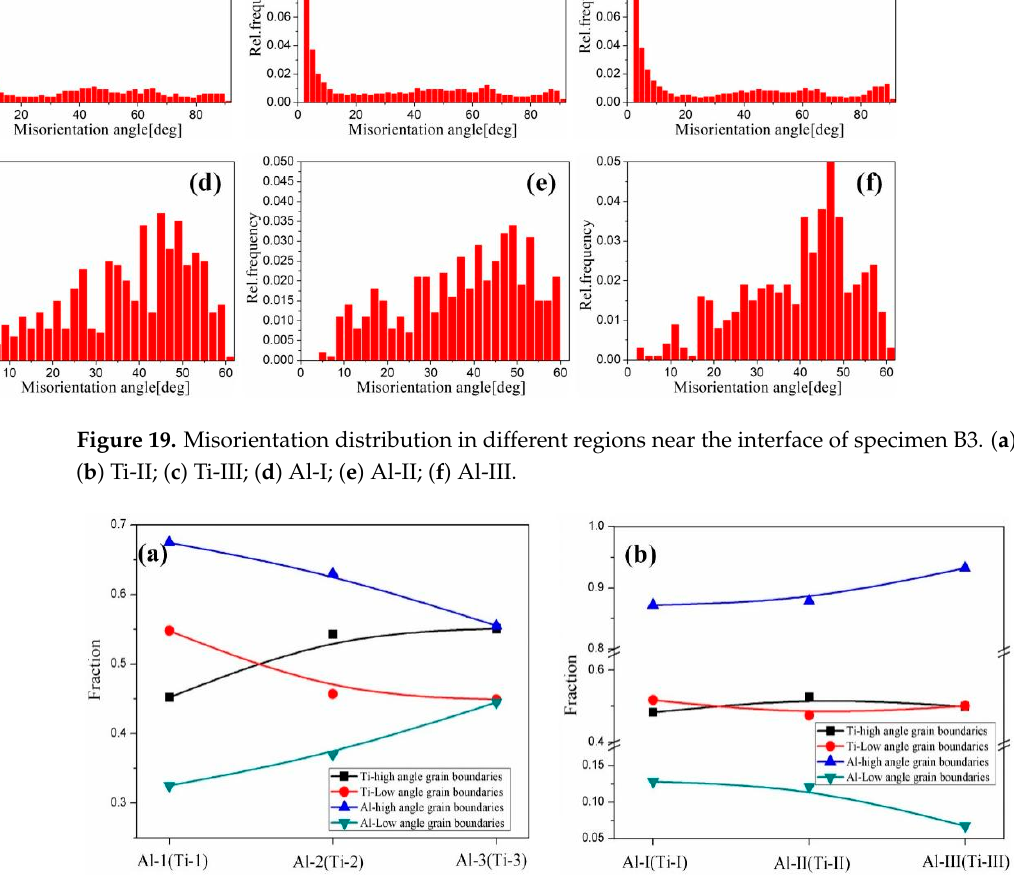
Figure 20. Variations in HAGBs and LAGBs in different regions near the interface. ( a ) Specimen B3; ( b ) specimen C3.